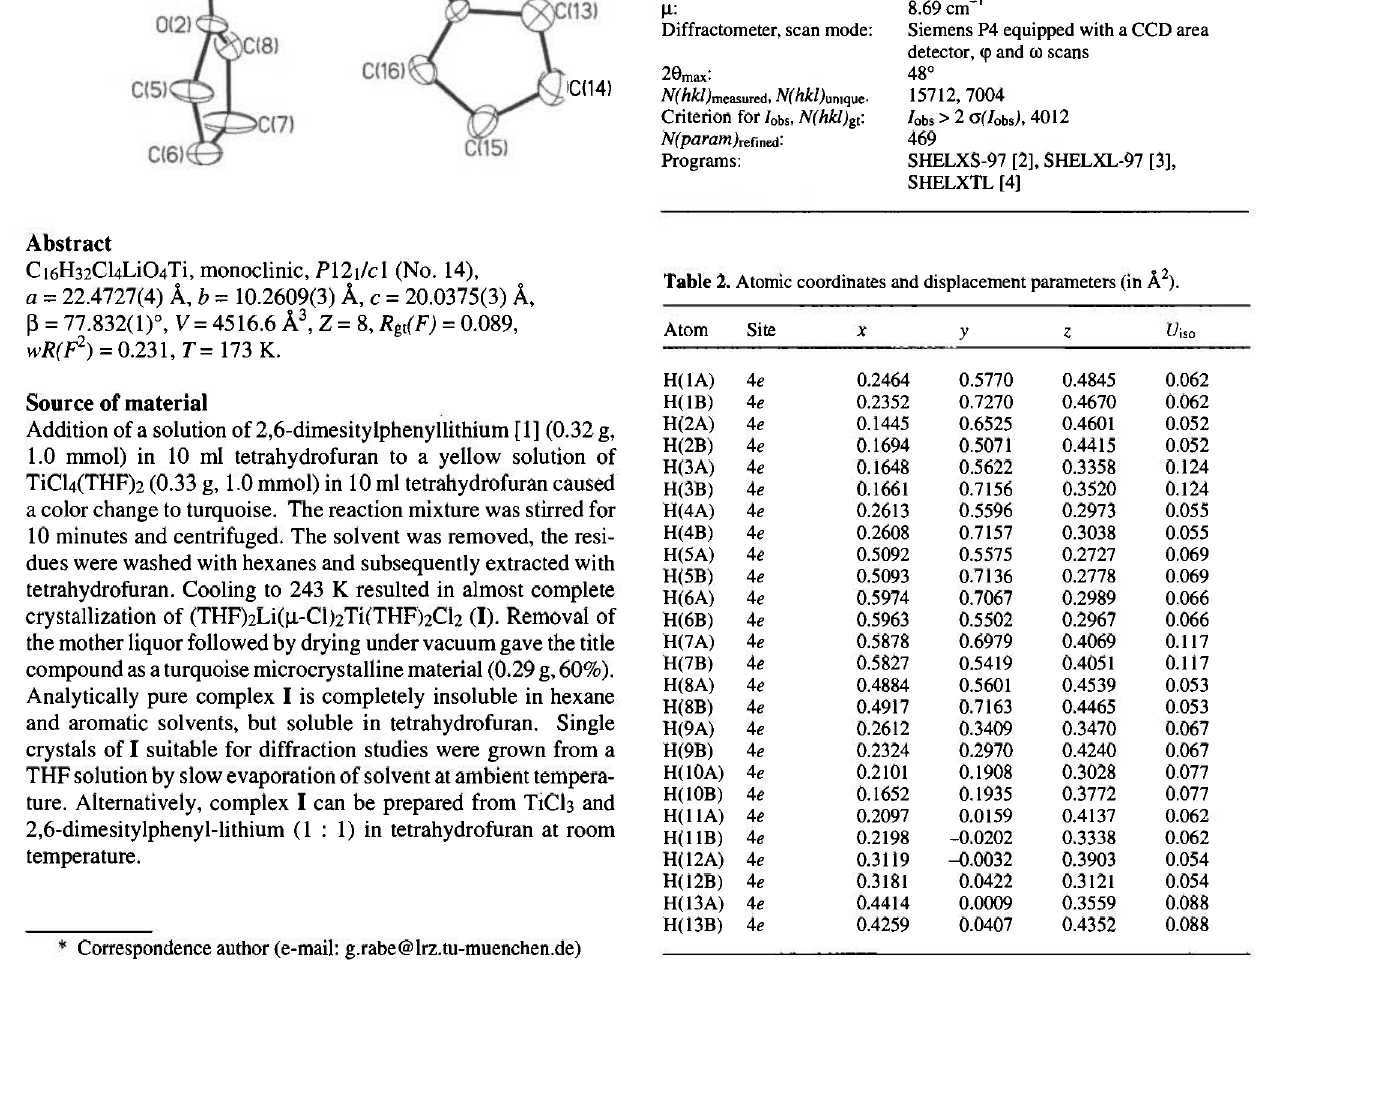
Table 1. Data collection and handling.